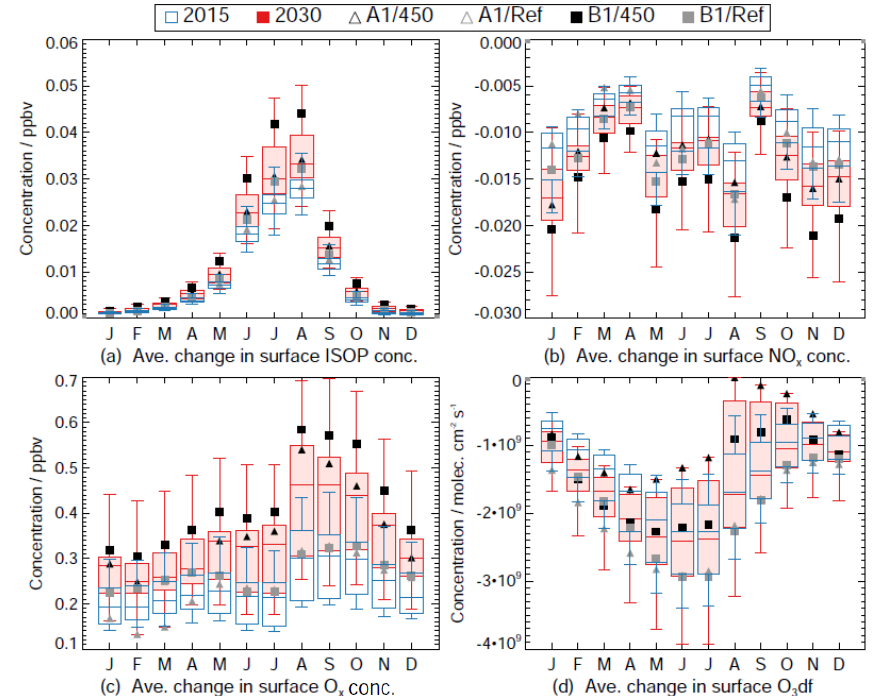
Fig. 11. Same as Fig. 7 but for Europe (Fig.